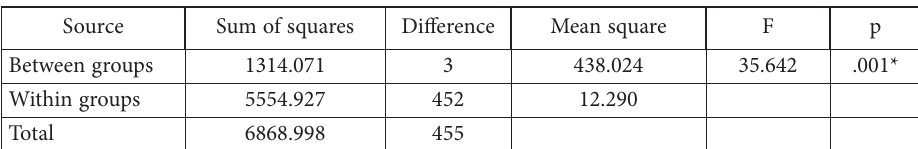
Table 2. One-way analysis of variance results for the Torrance Tests of Creative Thinking scores (source: created by author) Source Sum of squares Difference Mean square F p Between groups 1314.071 3 438.024 35.642 .001* Within groups 5554.927 452 12.290 Total 6868.998